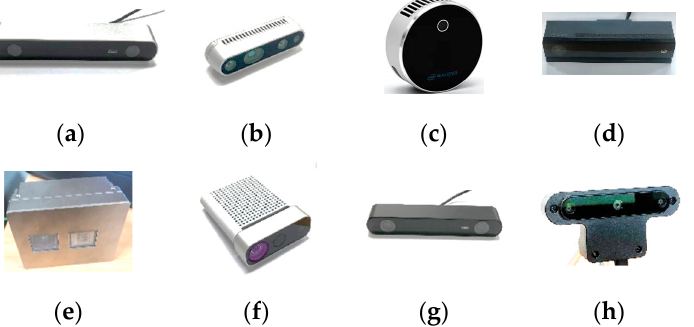
Figure 1. Images of depth cameras: ( a ) ZED, ( b ) RealSense D435, ( c ) RealSense LiDAR L515, ( d ) Kinect v2, ( e ) Basler Blaze 101, ( f ) Azure Kinect, ( g ) ZED 2 and ( h ) OAK-D.